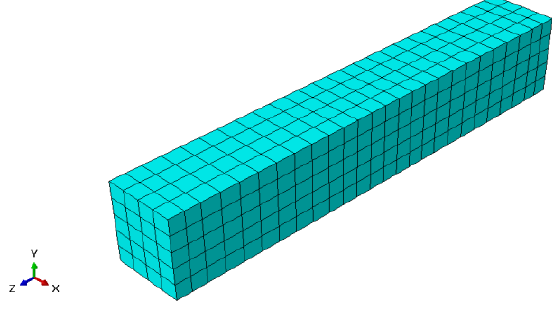
Figure 8. Meshing of beam created in ABAQUS.